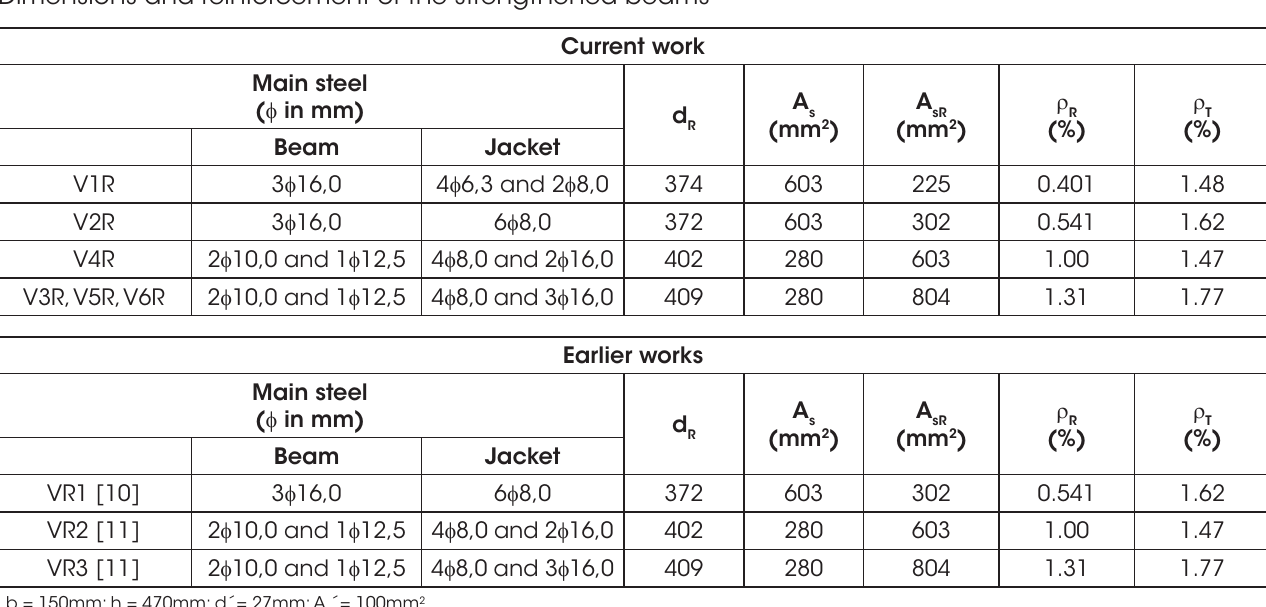
Dimensions and reinforcement of the strengthened